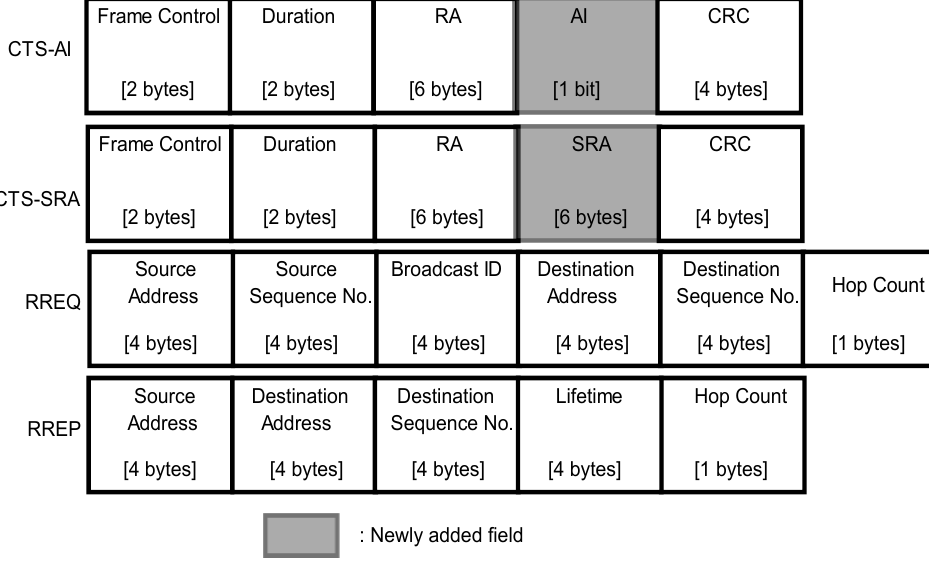
Figure 3. Control